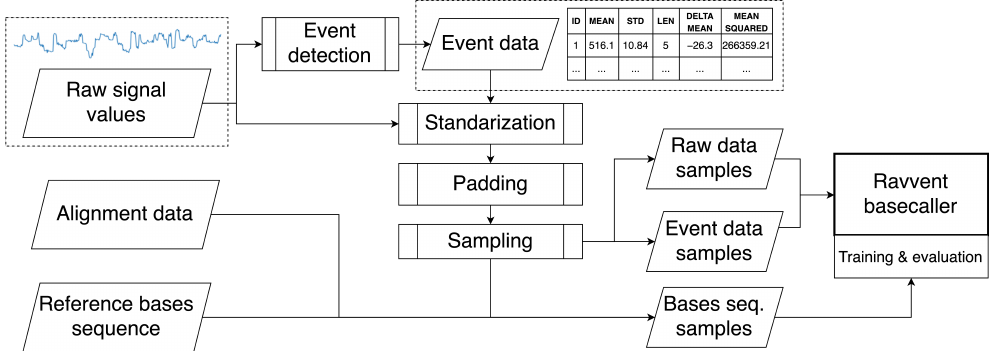
Figure 2. Data preparation pipeline. Our algorithm called Ravvent uses raw data, events, and ground-truth